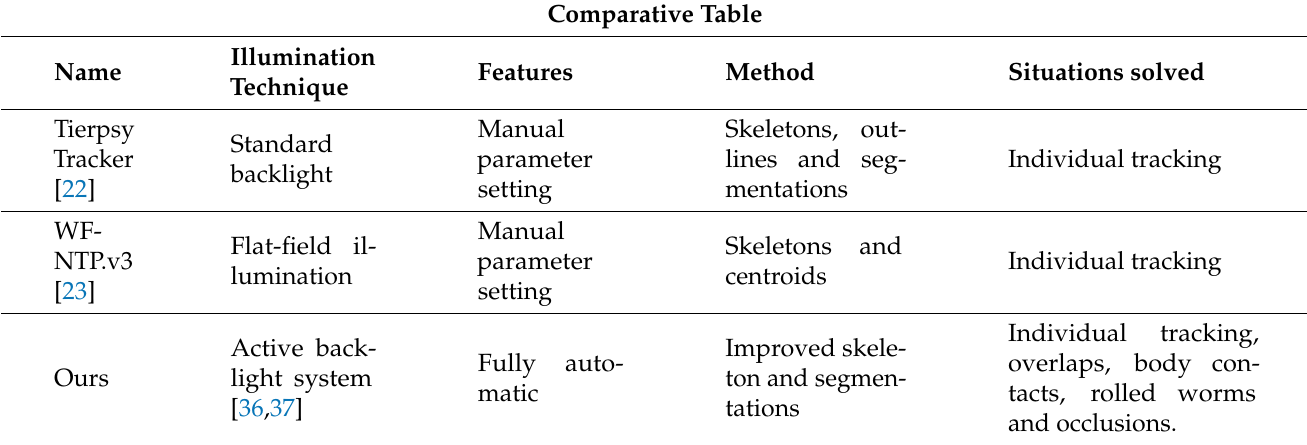
Table 1. Comparison with other multi-trackers. This table shows the comparison of our multi-tracker with respect to others (tierpsy-tracker [22], WF-NTP.v3